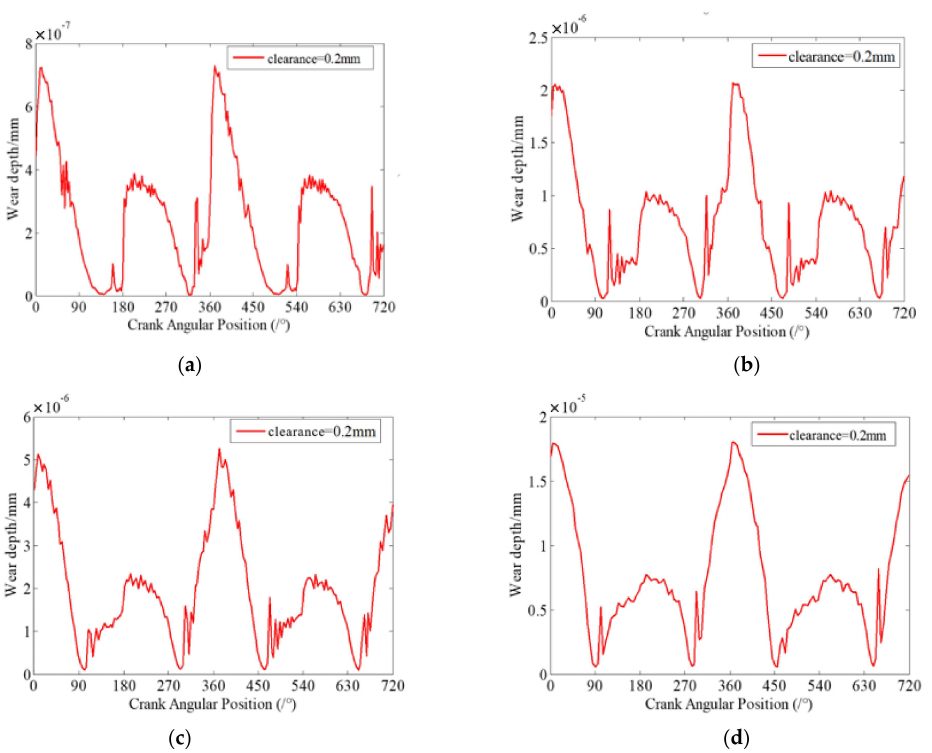
Figure 11. Dynamic wear depth in revolute clearance joint A for different driving speeds. ( a ) 200 rpm;